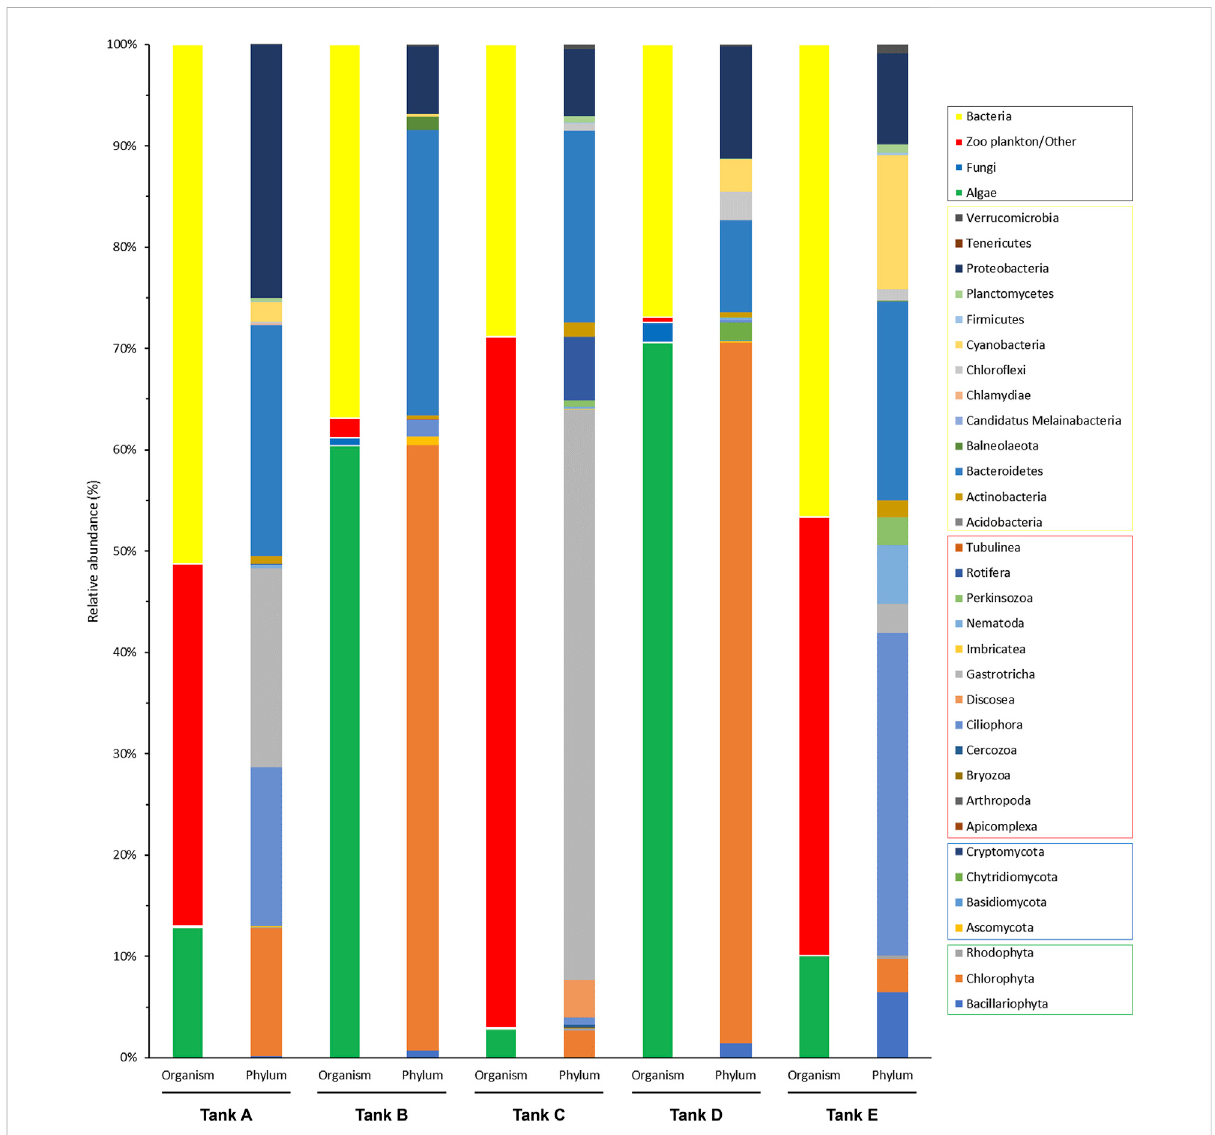
FIGURE 3 Community composition of the organism groups and phyla from the fi ve tanks. The four organism groups that composed the microbial communities in each tank and the phyla from each group are indicated (black box, organism groups; yellow box, bacterial phyla; red box, zooplankton/other related phyla; blue box, fungal phyla; green box, algal phyla). The data underlying all the graphs indicated in this fi gure can be found in Supplementary Tables S1,